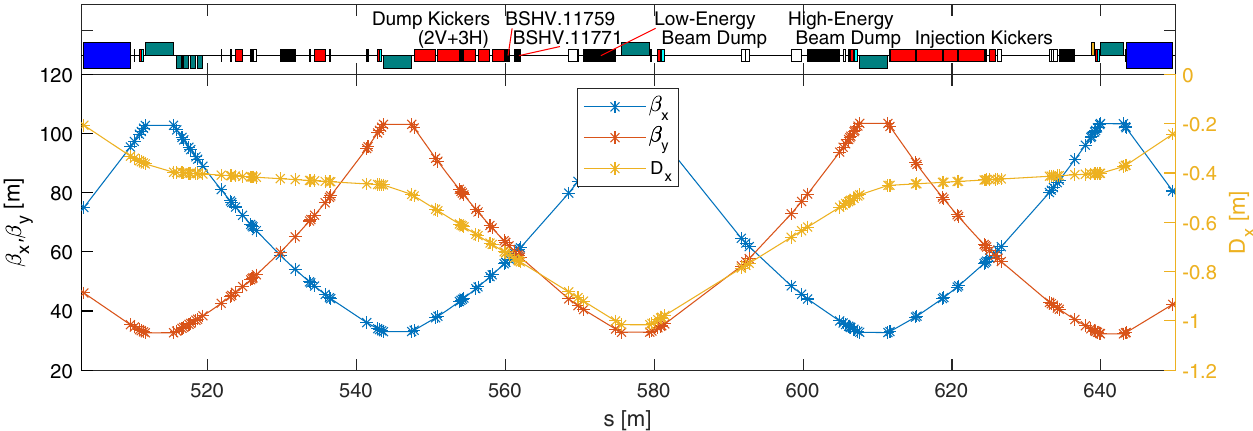
FIG. 1. Layout (upper frame) and linear optics functions (lower frame) of LSS1. Scrapers, injection and dump kickers, as well as dump absorbers are highlighted.